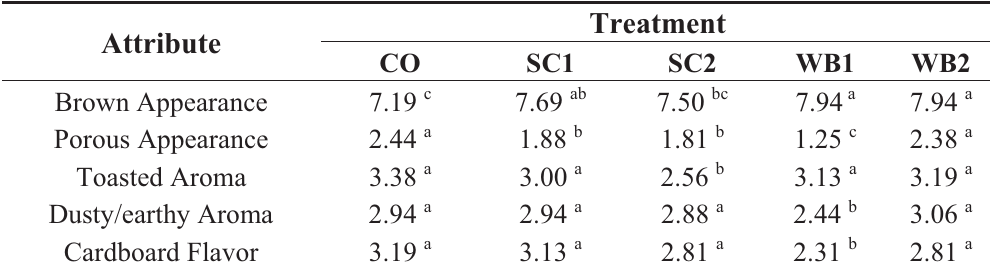
Table 3. Average appearance, aroma, and flavor attribute intensity scores for coated treatments. Significantly different attributes showed only ( p <